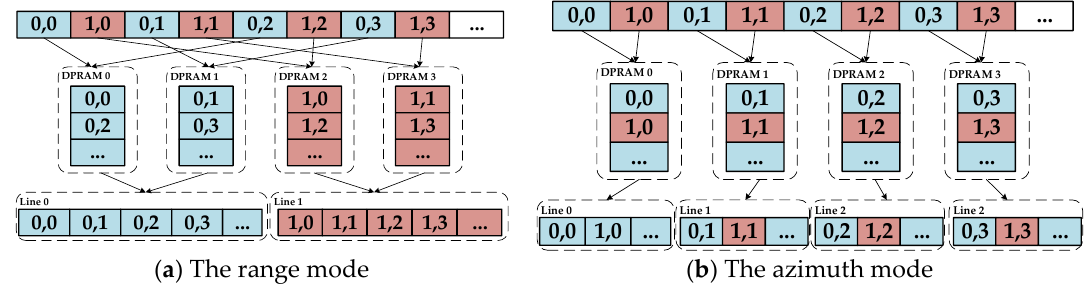
Figure 10. Two-dimensional data read mode.